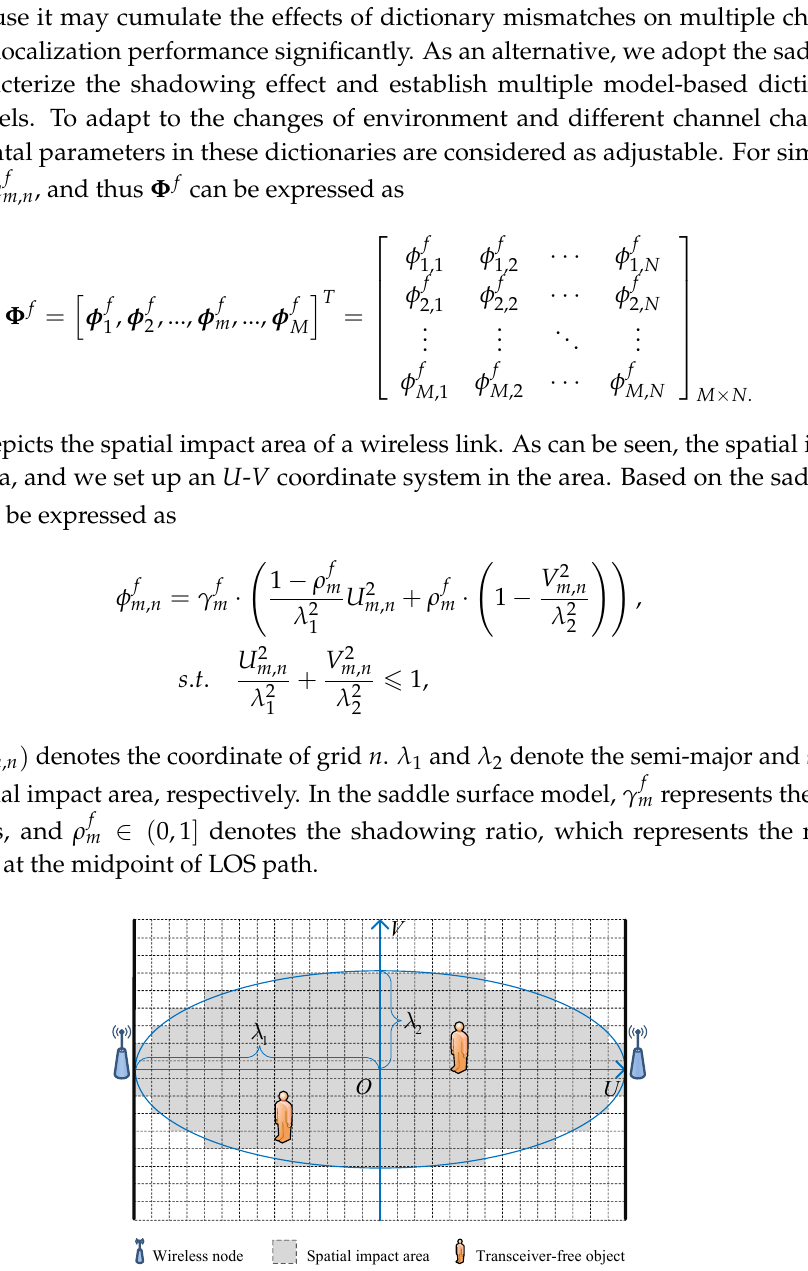
Figure 2. Spatial impact area of a wireless